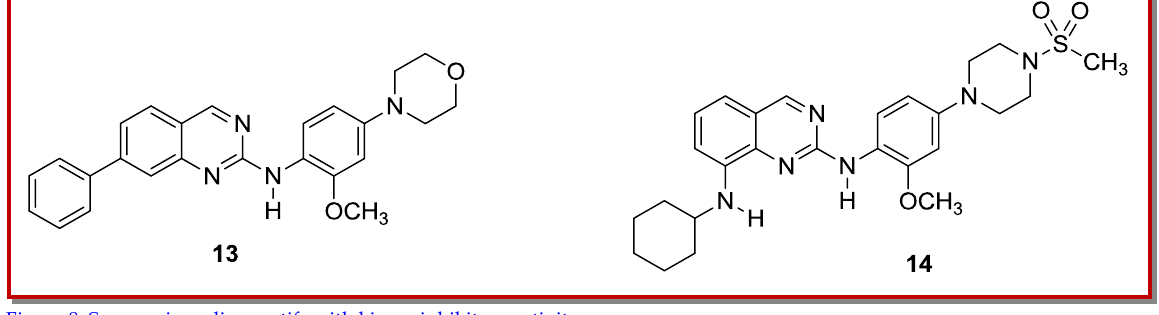
Figure 8: Some quinazoline motifs with kinase inhibitory activity